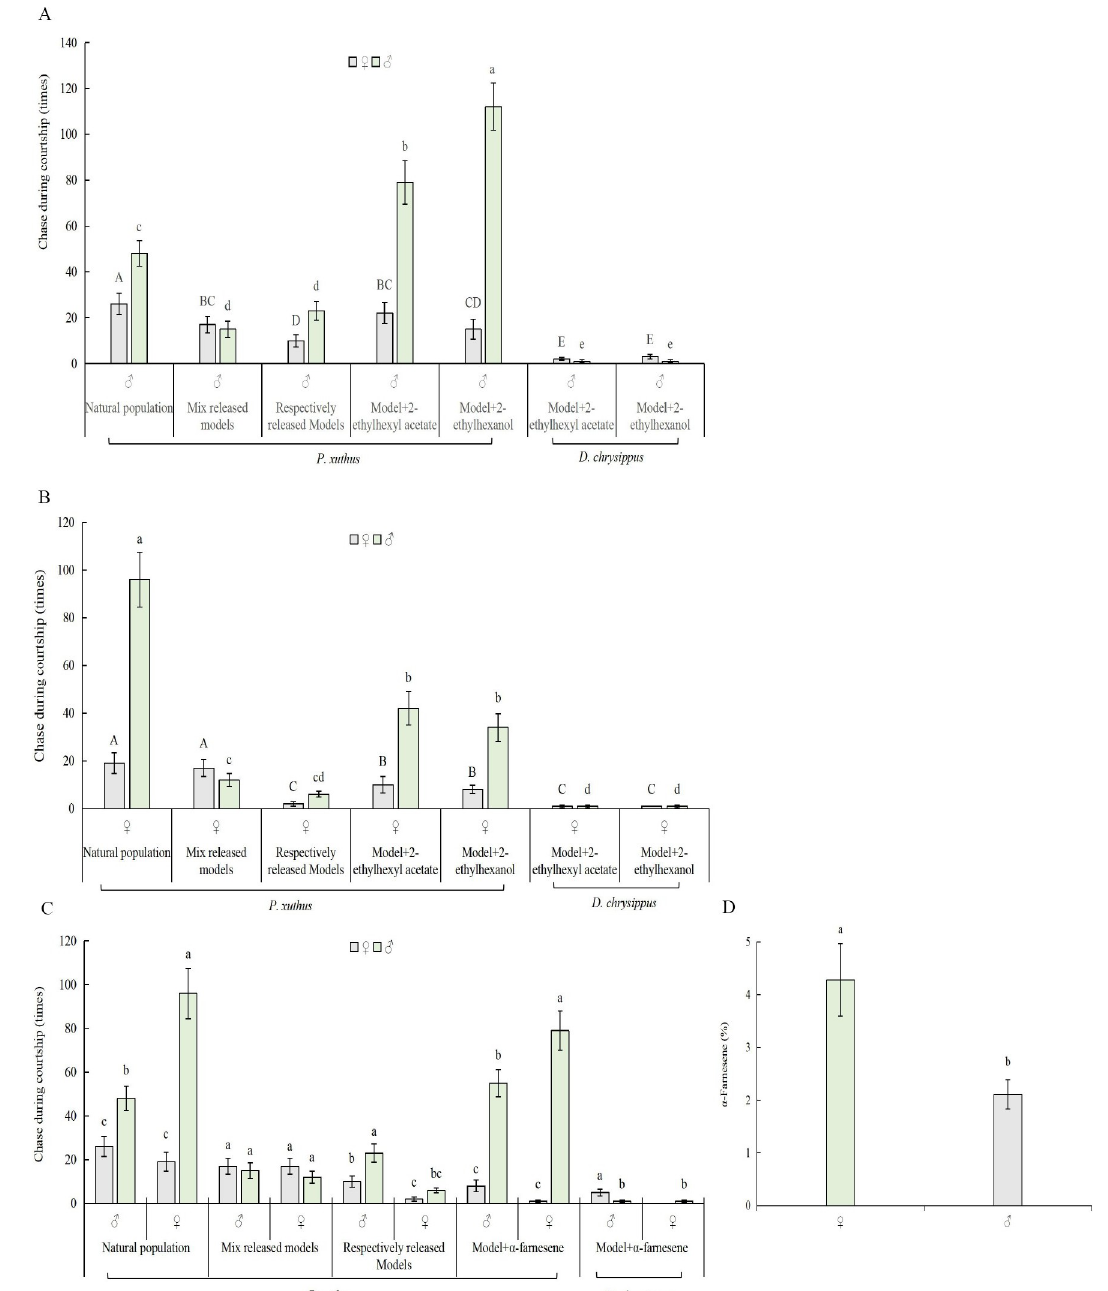
Fig 5. Chasing behavior of the butterfly P . xuthus to VOCs during courtship. A. Chasing number between males and females to butterfly males models applied with 2-ethylhexyl acetate and 2-ethyl-1-hexanol. B. Chasing number between males and females to butterfly females models applied with 2-ethylhexyl acetate and 2-ethyl-1-hexanol. C. Impact of α -farnesene on the chasing behavior of the butterflies: P . xuthus and D . chrysippus . D. Abundance of α -farnesene in females and males of P . xuthus . Notes: Capital letters indicate significant differences between the female butterfly chasing the model (P < 0.05) (N = 21, LSD method) in Fig 5A, 5B, lowercase letters indicate significant differences between the male butterfly chasing model (P < 0.05) (N = 21, LSD method) in Fig 5A, 5B. Lowercase letters indicate significant differences between the four types of chasing behavior (P < 0.05) (N = 12, LSD method) in Fig 5C. Different lowercase letters above bars indicate significant differences in the abundance of α -farnesene between males and females (P < 0.05) (F-test, N = 6) in Fig